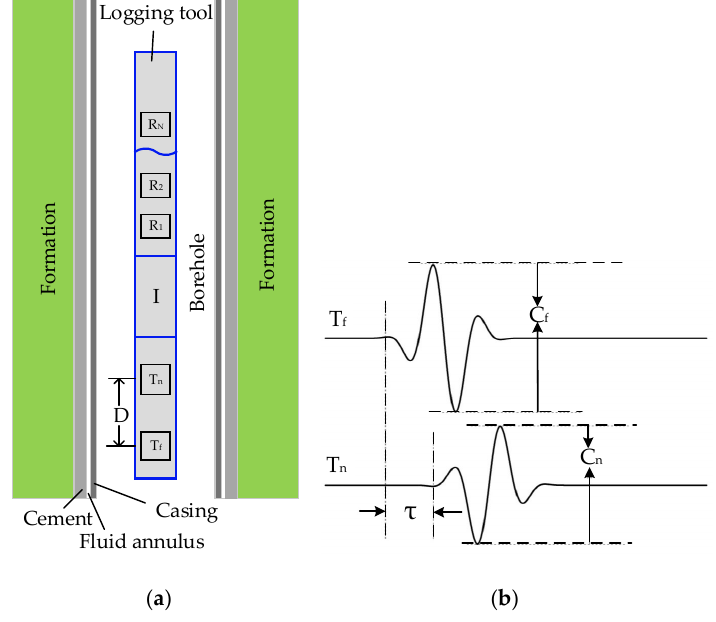
Figure 1. Dual ‐ source logging tool model in the cased ‐ hole well ( a ), and excitation signals for the Figure 1. Dual-source logging tool model in the cased-hole well ( a ), and excitation signals for the far far and near transmitting transducers ( b ). and near transmitting transducers ( b